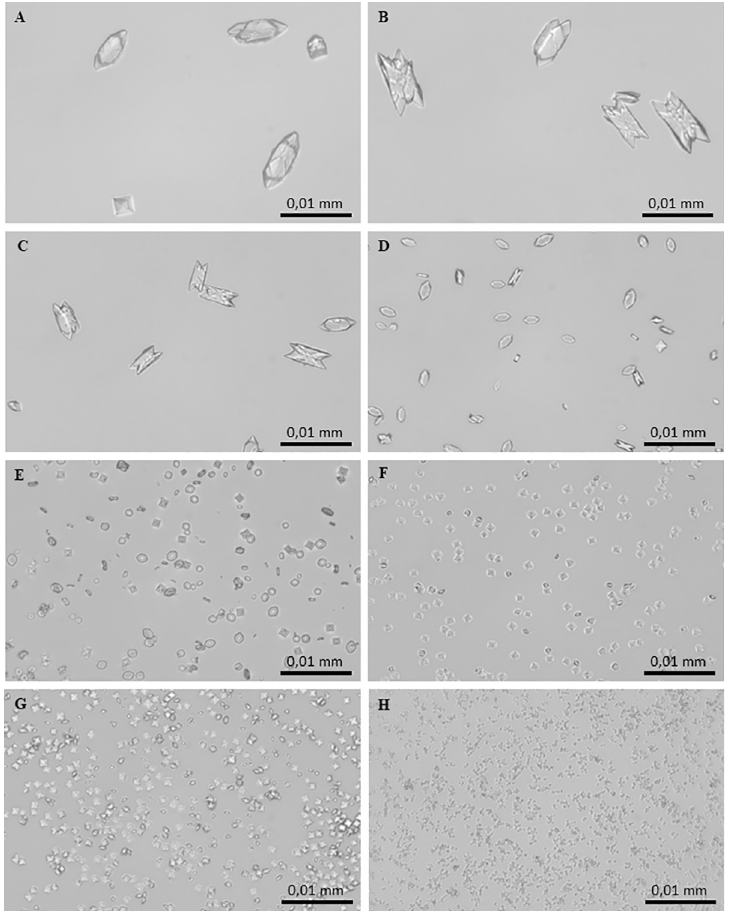
Fig 4. Light micrographs of CaOx crystals grown in the absence and presence of C . officinarum AE increasing concentrations. (A) and (B) Controls; (C) AE, 2 μ g dw/ml; (D) AE, 30 μ g dw/ml; (E) AE, 125 μ g dw/ml; (F) AE, 200 μ g dw/ml; (G) AE, 500 μ g dw/ml; (H) AE, 1000 μ g dw/ml. Magnification was 400x for all panels.